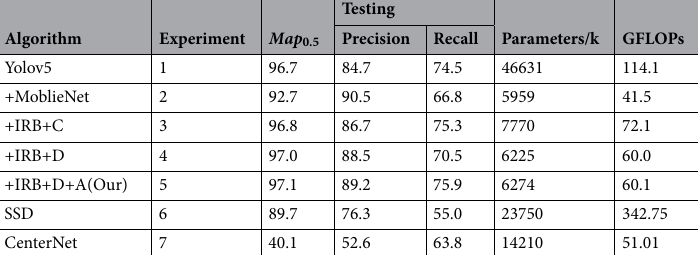
Table 2. Qualitative comparison of